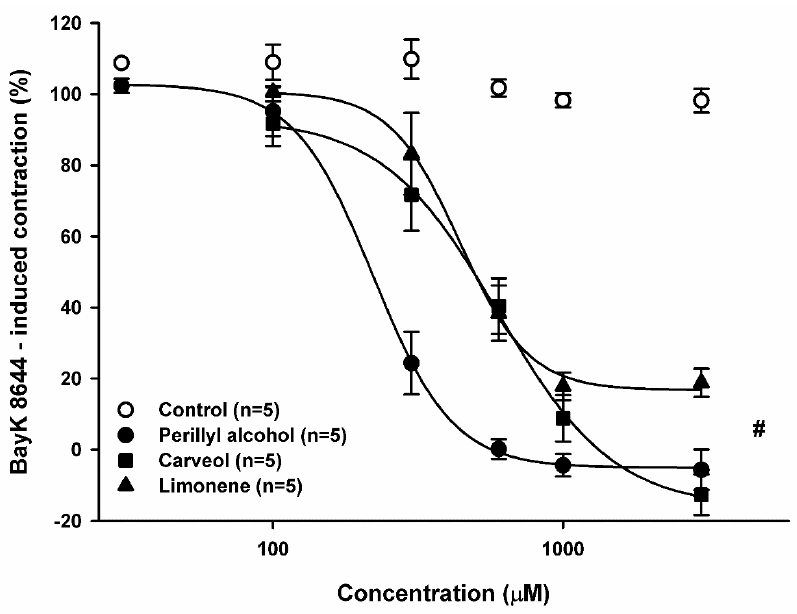
Figure 5. Relaxant Effect of perillyl alcohol, carveol, and limonene on sustained contractions induced by BayK-8644 (2 μM) in endothelium-denuded rat aortic rings. Results are shown as means ± SEM. # indicates statistical difference between limonene, carveol, and perillyl alcohol vs. control ( p < 0.05, two-way ANOVA and Holm-Sidak test). Each control consisted of the same concentration of vehicle as in the experimental case, but without the experimental substance.